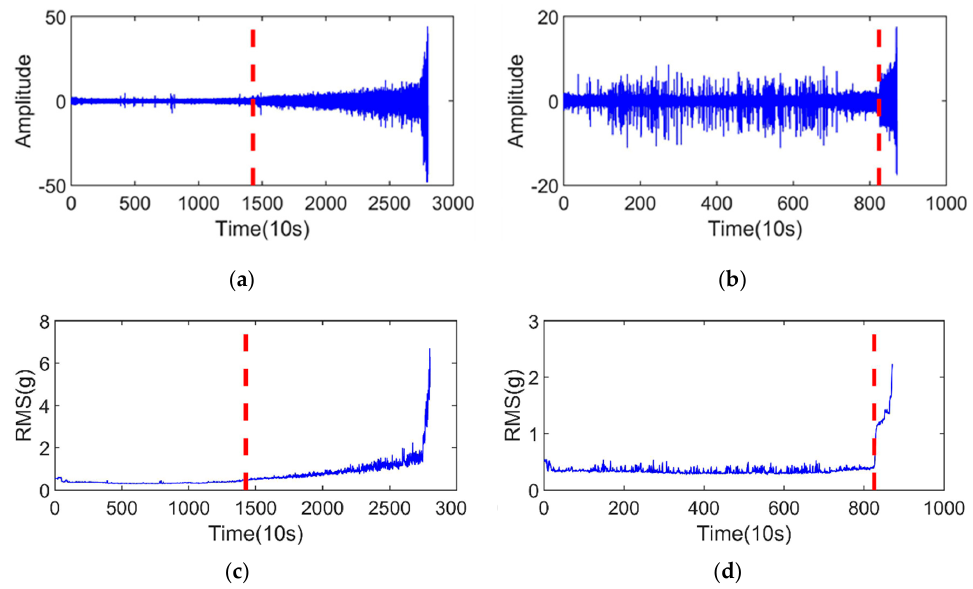
Figure 5. Vibration signals of the training sets and their RMS: ( a ) vibration signal of the bearing1_1; ( b ) vibration signal of the bearing1_2; ( c ) RMS of the bearing1_1; and ( d ) RMS of the bearing1_2. Appl. Sci. 2022 , 12 , x FOR PEER REVIEW After the SPT was determined, the data after SPT were processed. Each sample has